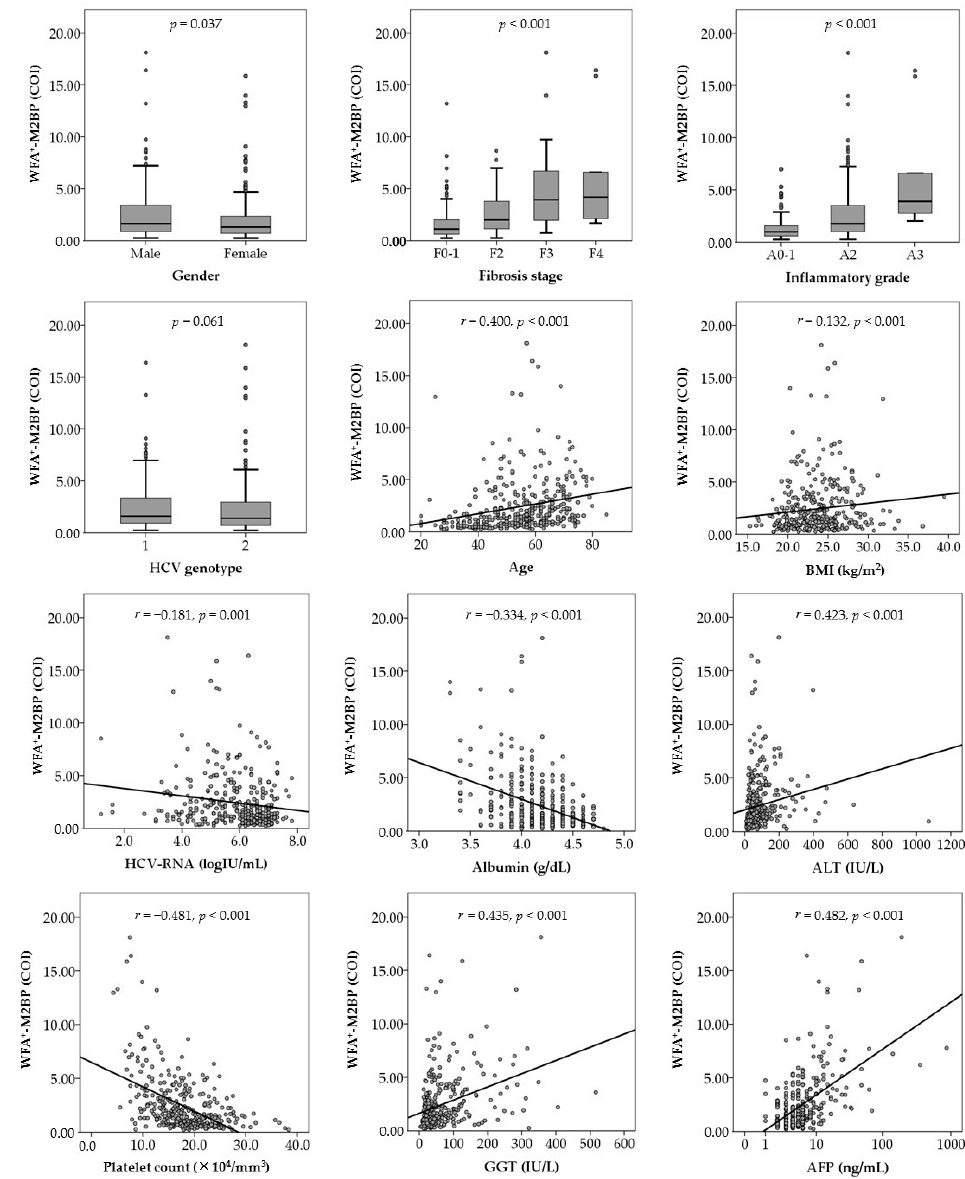
Figure 2. Relationships between Wisteria floribunda agglutinin-positive Mac-2-binding protein (WFA + -M2BP) levels and patient characteristics at baseline. The Mann–Whitney U test or Kruskal–Wallis test was used for the categorical data. Spearman’s rank correlation coef fi cient was used for the continuous data. AFP, α -fetoprotein; ALT, alanine aminotransferase; BMI, body mass index; GGT, γ -glutamyl transpeptidase; HCV, hepatitis C virus.